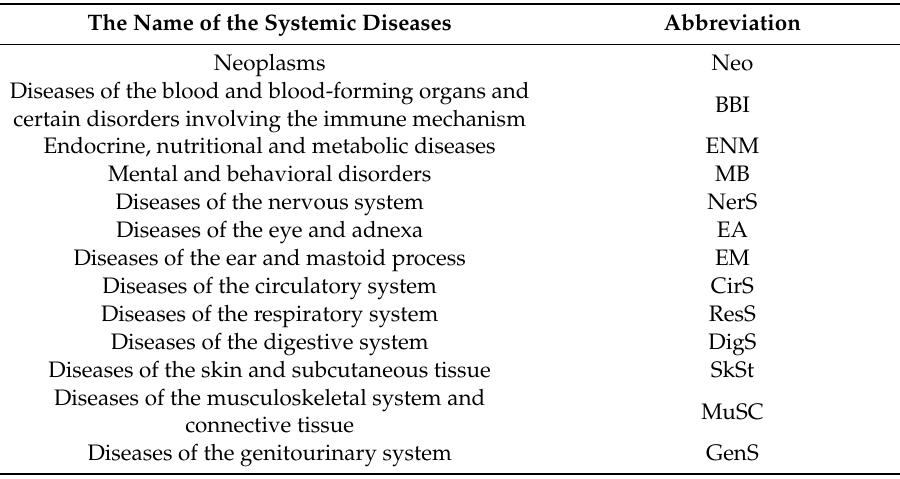
Table 2. The Abbreviation of the 13 systemic diseases.